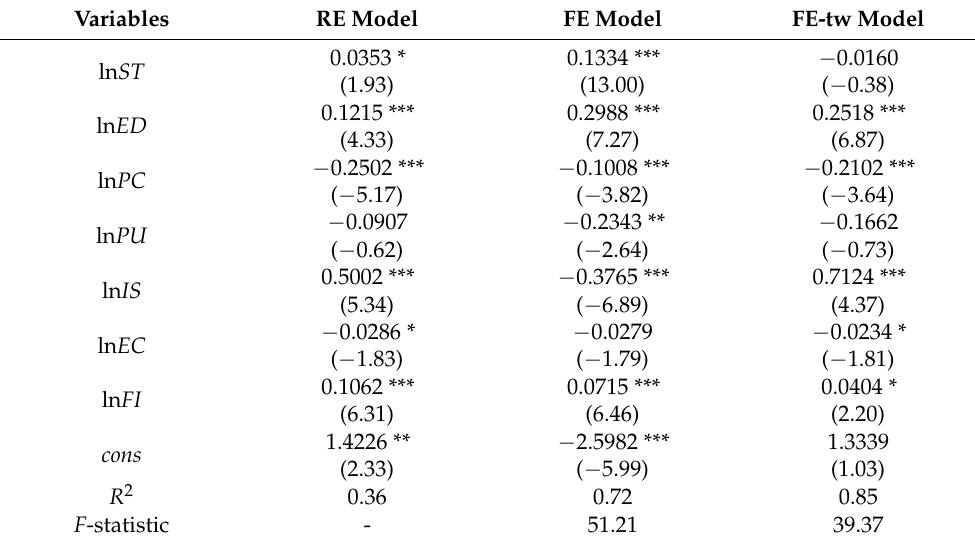
Table 6. CEE ’s regression